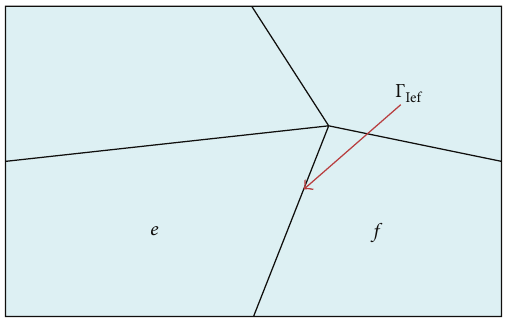
Figure 3: Illustration of continuity between two adjacent elements “ 𝑒 ” and “ 𝑓